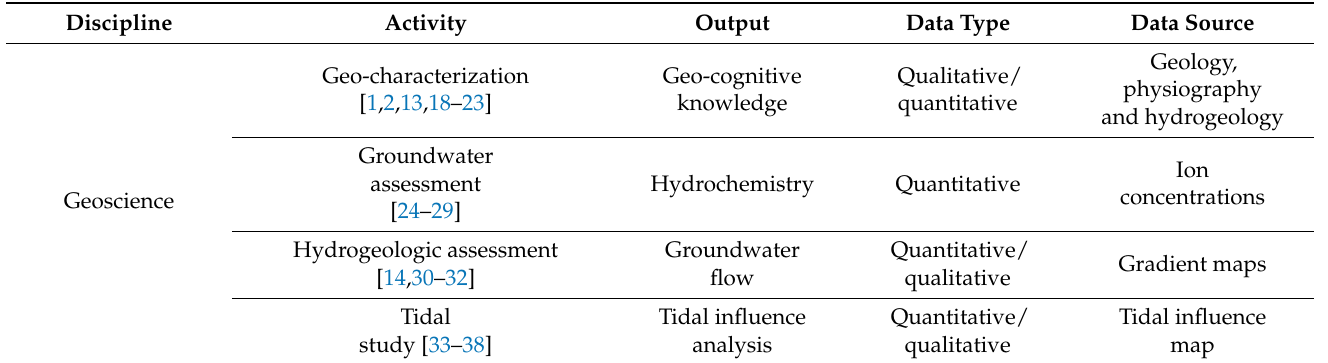
Table 1. FLAP Interdisciplinary Resource Matrix.